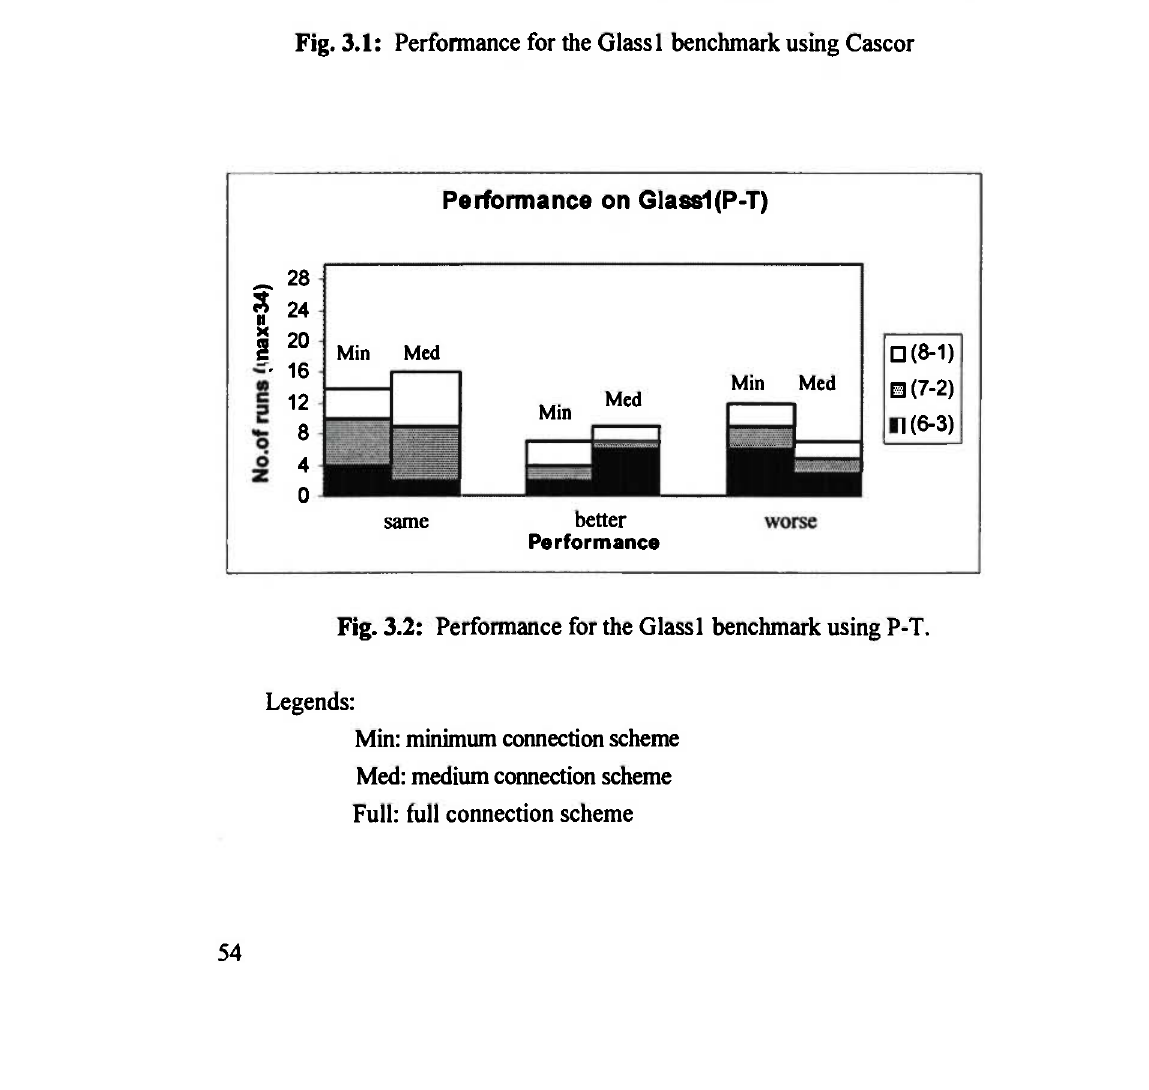
Fig. 3.1: Performance for the Glass 1 benchmark using Cascor